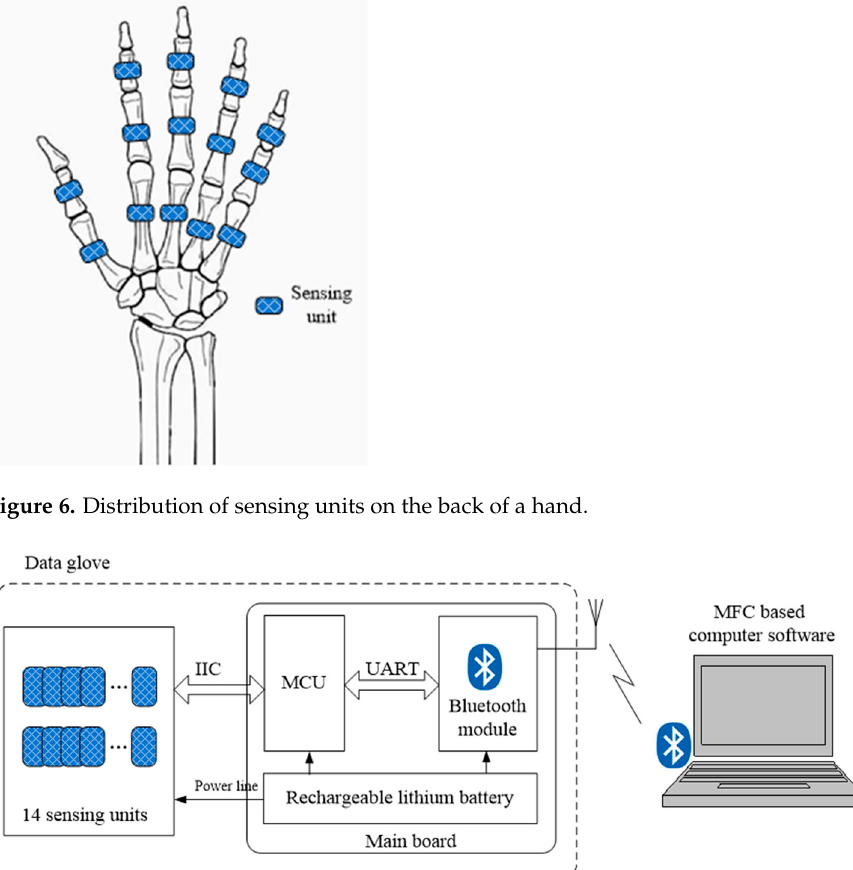
Figure 8. Photo of the designed wireless data glove.